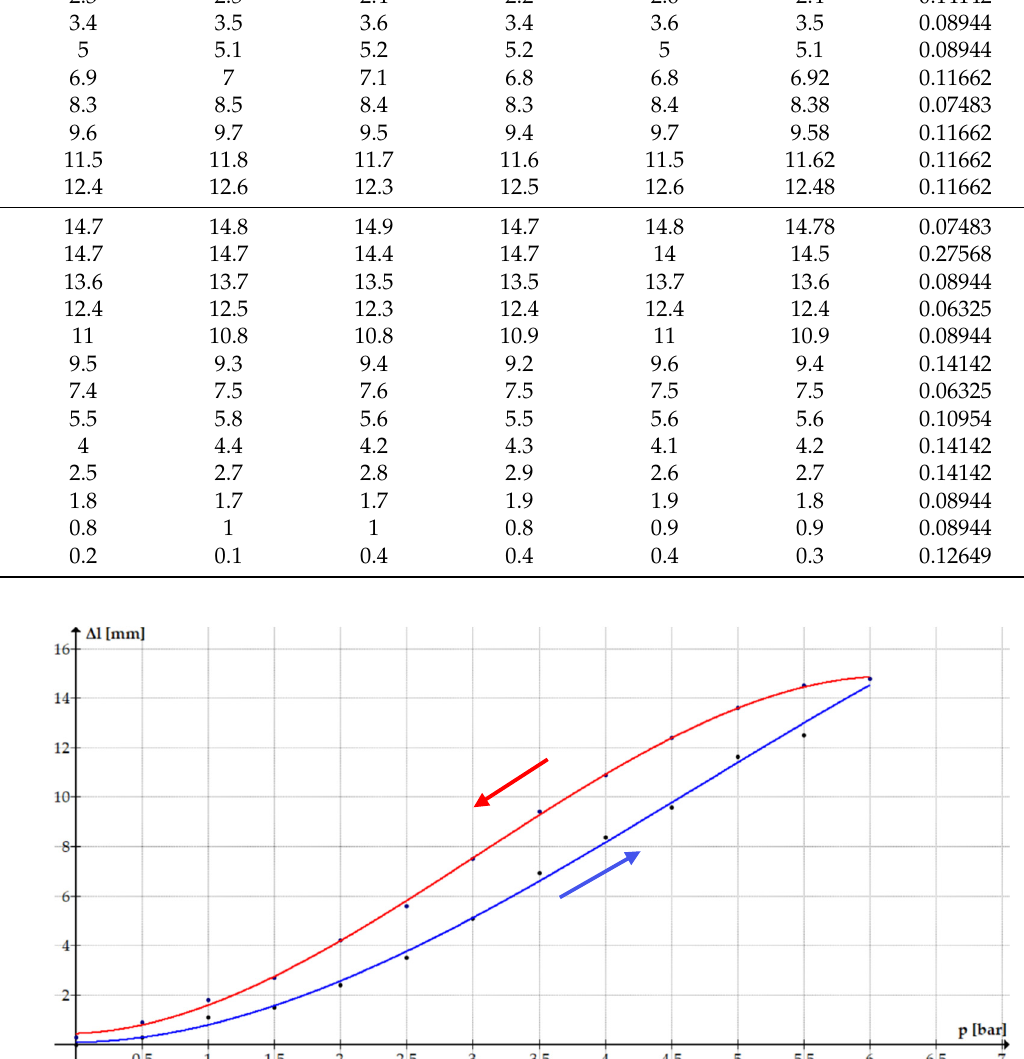
( b ) Figure 8. Polynomial regression. ( a ) Inflation; ( b ) deflation.